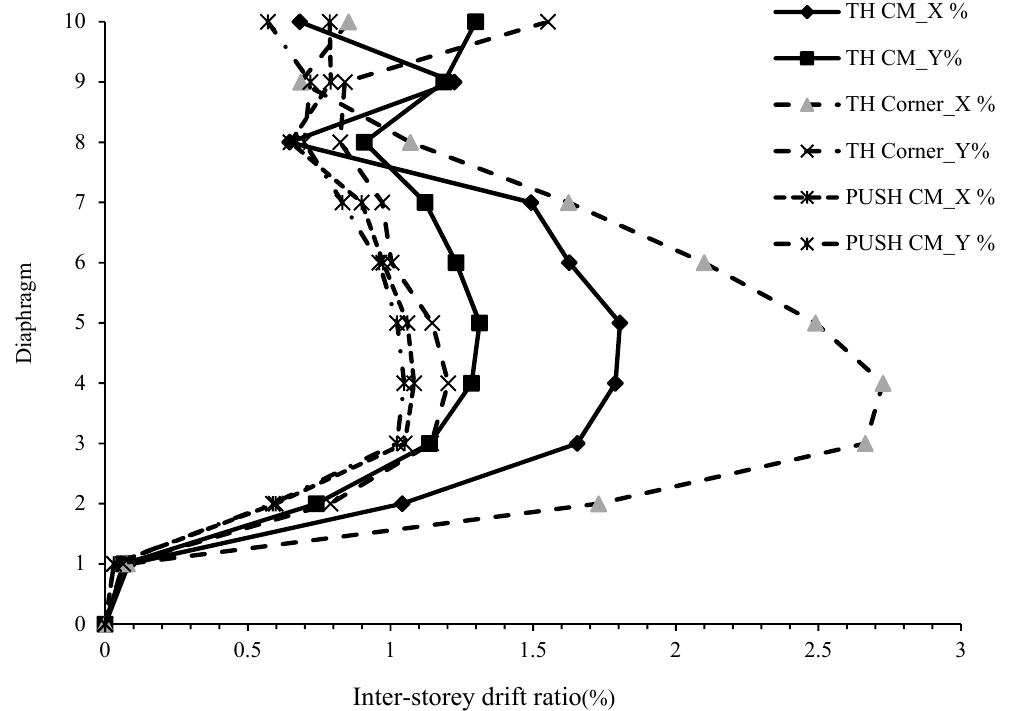
Figure 10. Inter ‐ storey drift ratio for the 0.36 g PGA input. In figure, TH indicates the time history analysis and PUSH indicates the pushover analyses conducted in both x ‐ and y ‐ directions.